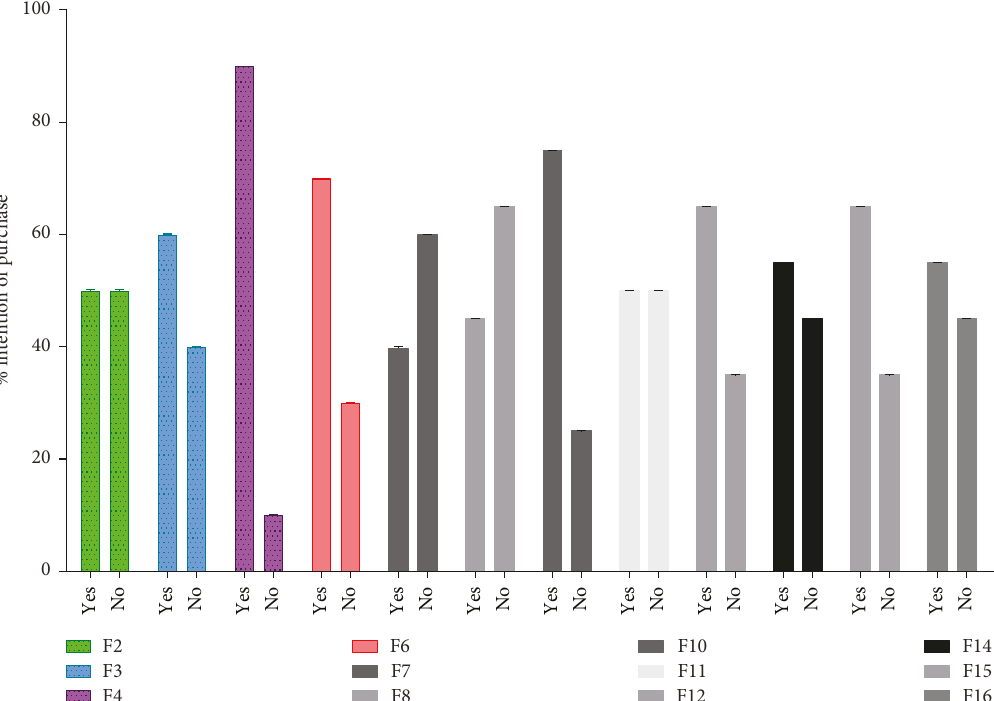
Figure 14: Percentage of intention of purchase of the product by the panelists for the di ff erent